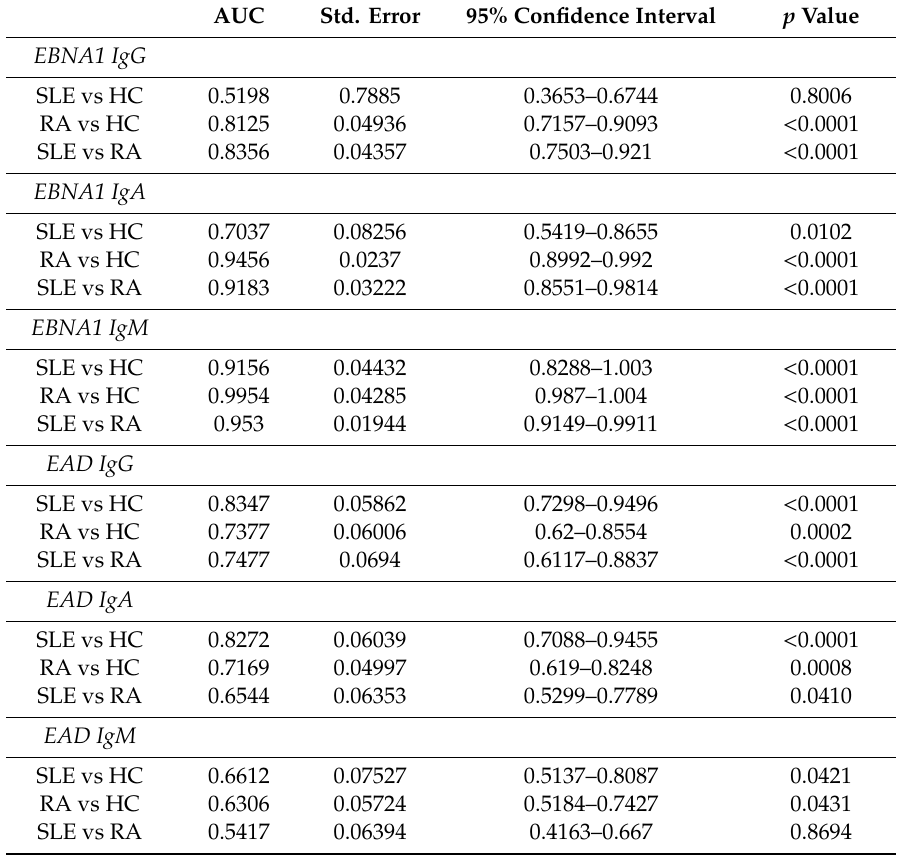
Table 1. IgG, IgA, IgM antibodies to EAD and EBNA1 in SLE ( n = 27), RA ( n = 77) and HC ( n = 29). Overview of the best discrimination test with AUC >